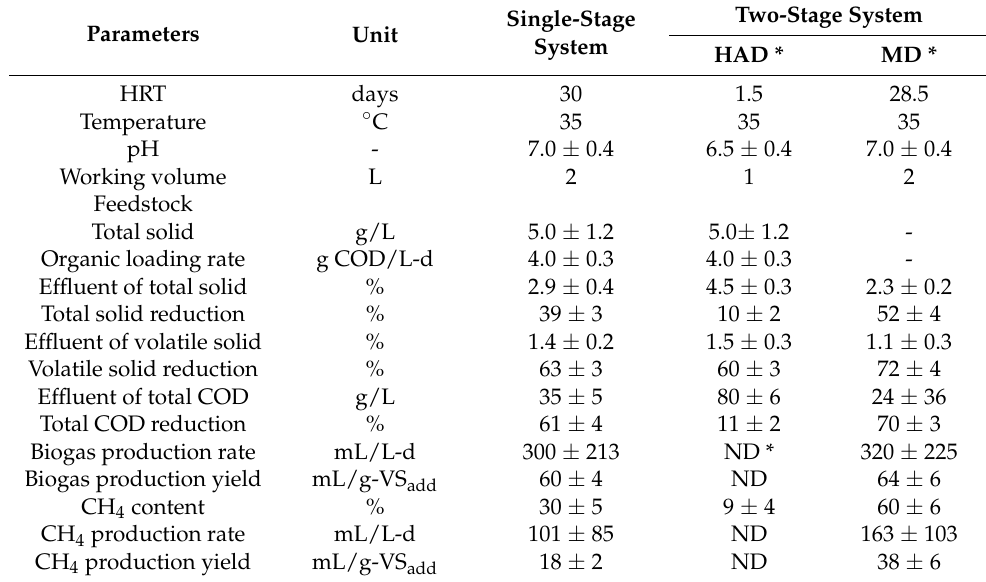
Table 5. Performance of single-stage and two-stage production